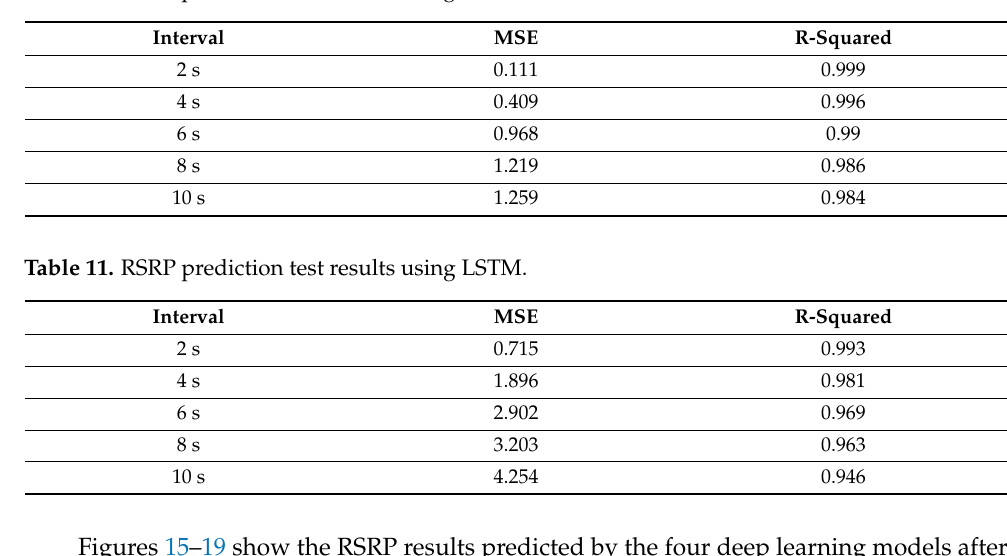
Table 10. RSRP prediction test results using RNN.